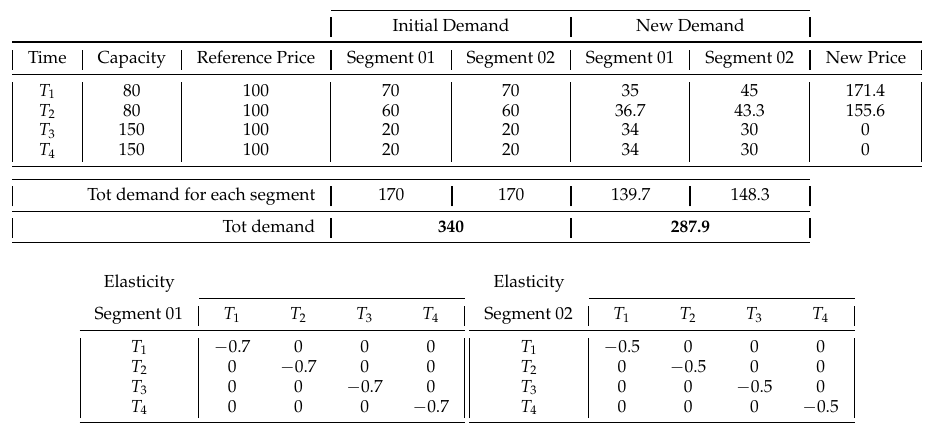
Table 6. Case Study 6.02—basic sub-case, data, and